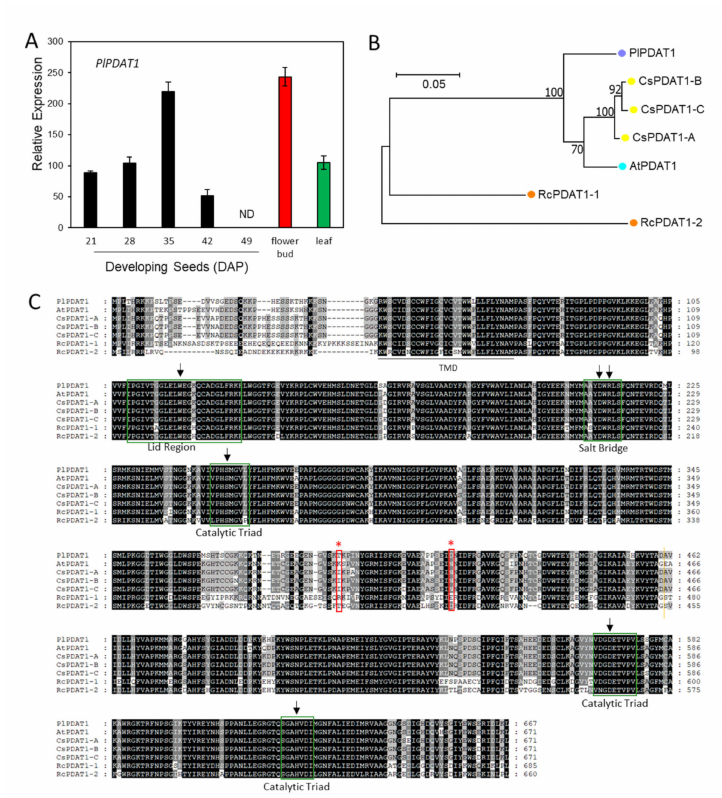
Figure 11. Characterization of PDAT1s in various species. ( A ) Relative expression level of PlPDAT1 in the developing seed, flower, and leaf tissue by qRT-PCR. DAP; day after pollination. ( B ) Phylogenetic tree of PDAT1 proteins from Physaria lindheimeri (Pl), Arabidopsis thaliana (At), Camelina sativa (Cs), Ricinus communis (Rc). ( C ) Protein alignment of PDAT1s. Putative transmembrane domains are underlined. The Thr and Asp corresponding to the aa at the 390th and 415th positions of PlPDAT1 are indicated by red asterisks and boxes. Green boxes indicate lid region, salt bridge, and catalytic triad [126], where conserved Trp (W), Asp (D), Arg (R), and three coordinated amino acids Ser-Asp-His (or S-D-H) are indicated by arrows. Genbank accession numbers are listed in Supplementary File 6, Table